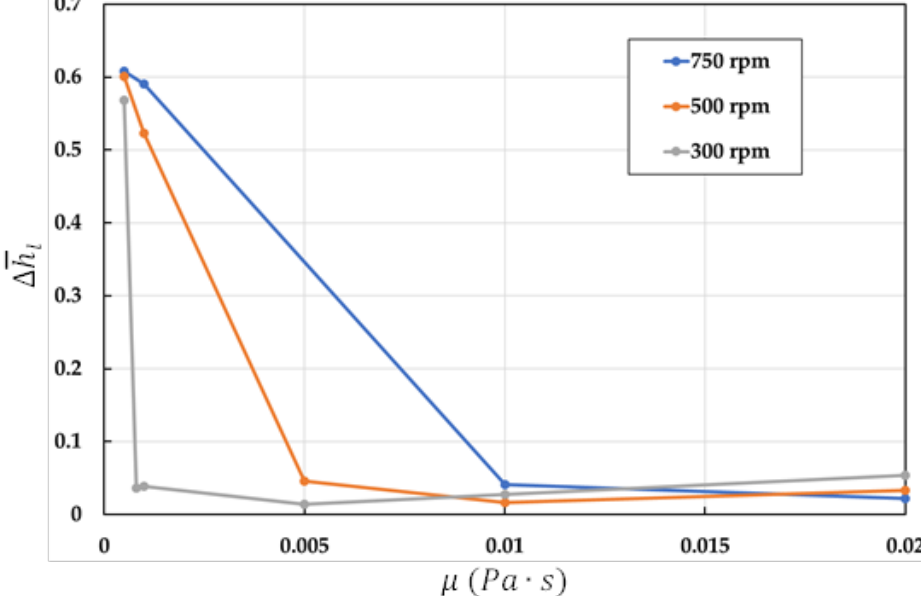
Figure 12. Dependence of the relative losses along the length on the coefficient of dynamic viscosity at different speeds of the at different speeds of the crankshaft.